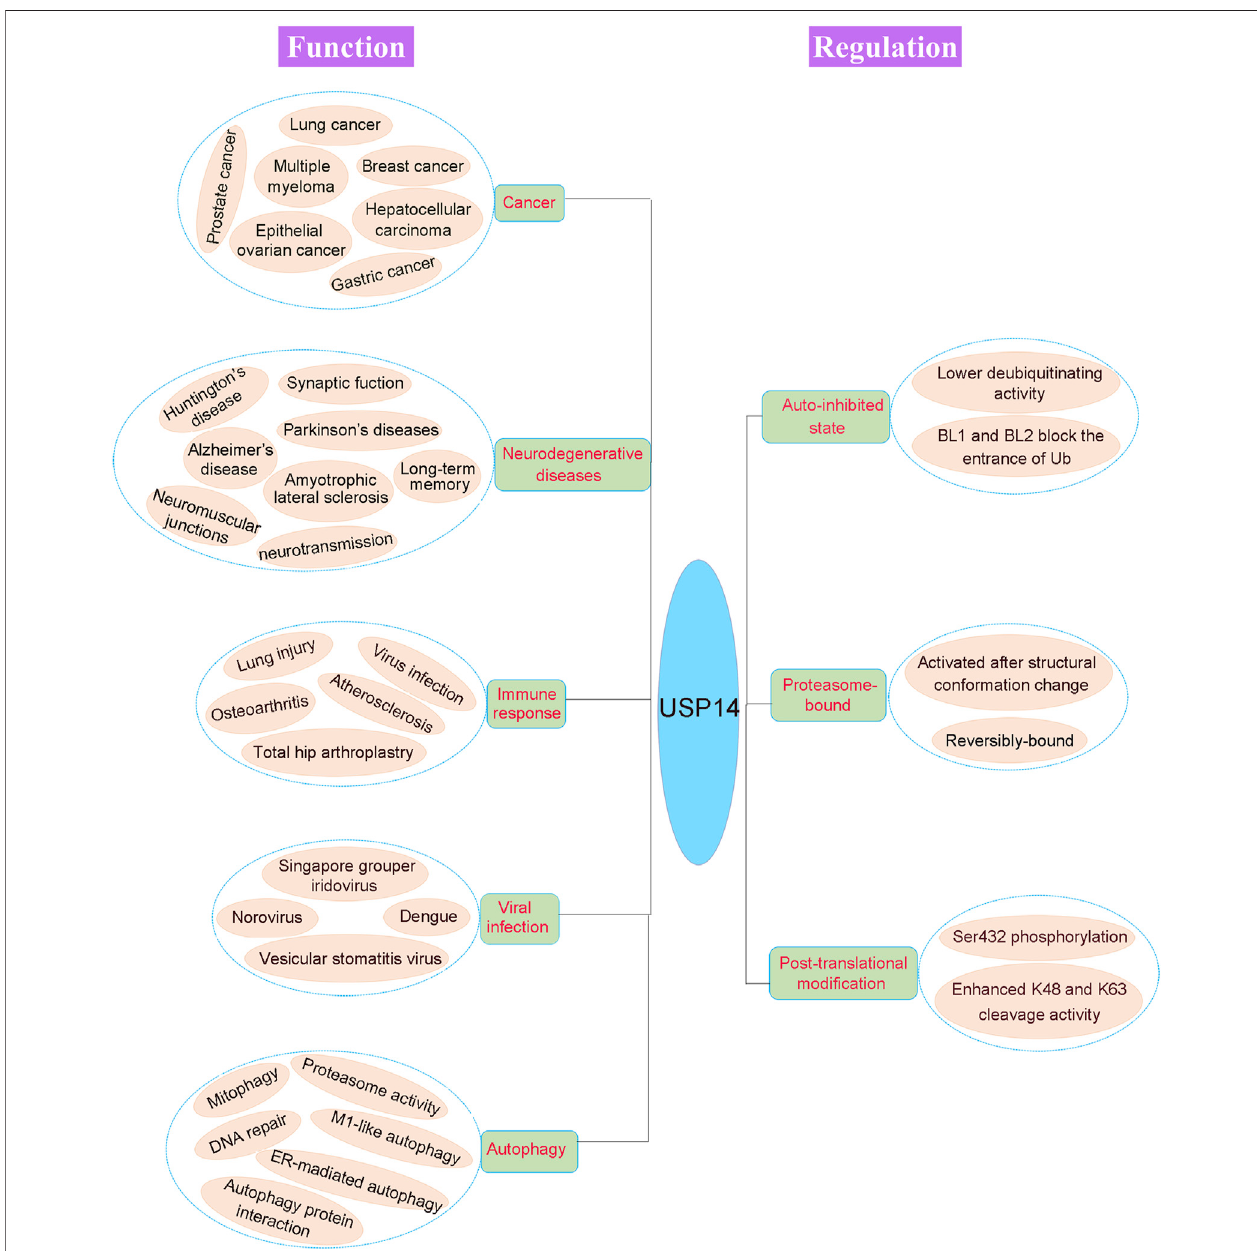
FIGURE 5 | Pathophysiological function and regulation of USP14. The physiological and pathological functions of USP14 are shown in the left of the fi gure. DysregulationofDUBcancausevariousdisease,including cancer, neurodegenerativediseases, immuneresponse,viralinfection and autophagy.Theactivity ofUSP14 isstrictlyregulatedasshownintherightofthe fi gure.USP14exhibitedanauto-inhibitedstatewithlowerdeubiquitinatingactivityastheauto-inhibitedconformation.And the proteasome-bound USP14 gained the deubiquitinating activity. Finally, phosphorylation of USP14 at Ser432 enhanced its K48 and K63 cleavage activity.